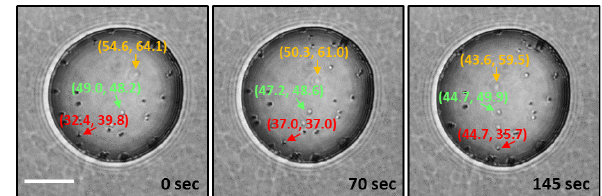
Figure 2. Optical images of SOM particles (isoprene sample 3 in Table 1) at 80% RH recorded during a typical bead-mobility exper- iment. Three beads have been labeled in these panels with different colors. Included are the x and y coordinates of these three beads which are used to determine average bead speeds in the particles. The size of the scale bar is 20µm.